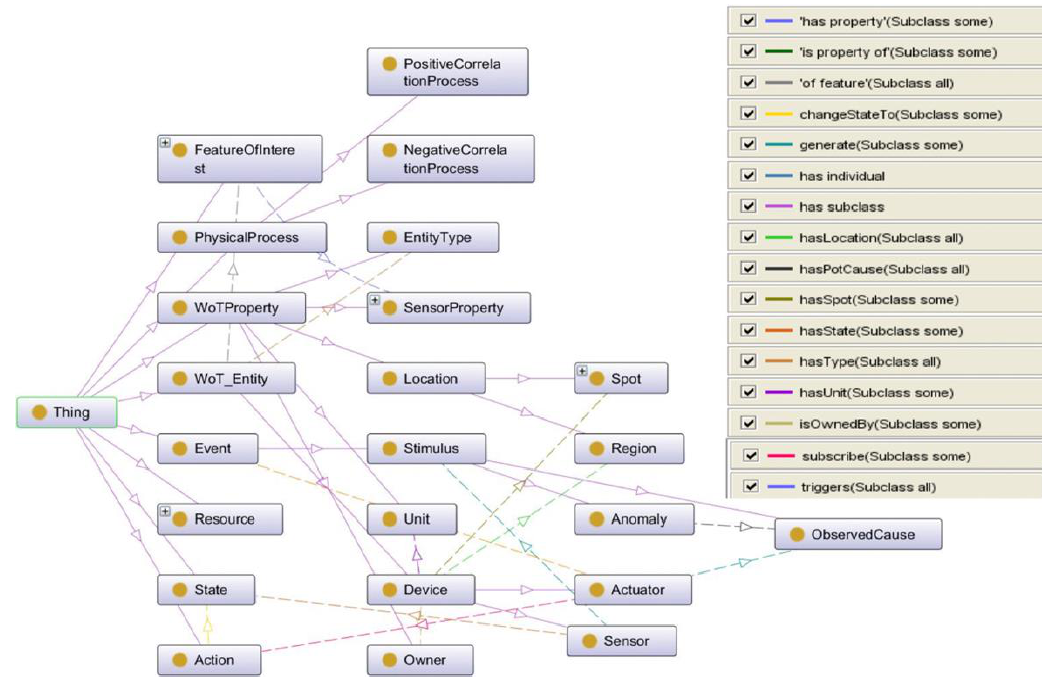
Figure 12. Building up the SWoT-O ontology for a building automation system with Protégé.